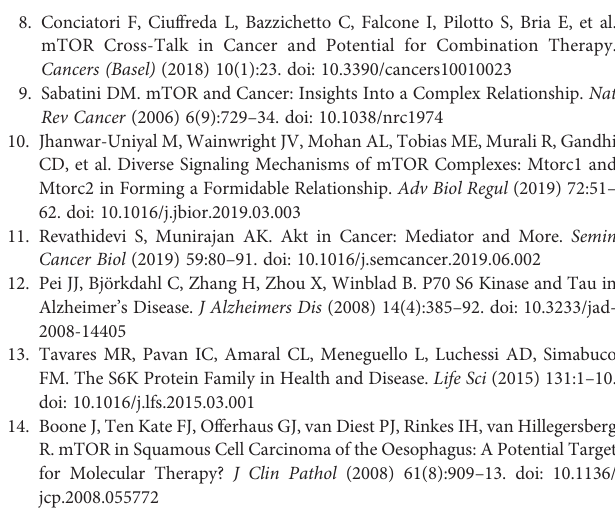
Supplementary Figure 1 | Effect of Ethyl ferulate on the activity of various kinases. (A, B) ABL, AKT1, AMPK a 1, AURUA, B-RAF, CDK2/Cyclin E, CDK4/ Cyclin D3, CHEK1, DNA-PK, EGFR, ERBB2, ERK1, FAK, FGFR1, FYN, GSK3 b , HIPK1, IKK a , JAK1, KIT, MEK1, MET, MKK6, MSK1, mTOR/FKBP12, NEK1, p70S6K, PAK4, PDK1, PI3K(p110 a /p65 a ), PIM1, PKC a , RSK2, SRC, TBK1, or TLK1 kinase and their respective substrates were incubated with or without Ethyl ferulate in an in vitro kinase assay. Data are shown as mean ± S.D of values. Supplementary Figure 2 | Expression of mTOR protein in mTOR knockdown cells. (A, B) Effect of mTOR knockdown on total or phosphorylated mTOR protein expression in KYSE450 (A) and KYSE510 (B) cells. KYSE450 and KYSE510 cells stably expressing shRNA control or shmTOR were analyzed by Western blotting. Band density was measured using the Image J (NIH) software program. For all experiments, similar results were observed from 3 independent experiments and band density is shown as a bar graph. One-way ANOVA was used to compare signi fi cant differences. Supplementary Figure 3 | Effect of Ethyl ferulate on ALT and AST activity. (A, B) The effect of Ethyl ferulate on ALT (A) and AST activity (B) was determined. Mice were orally administrated Ethyl ferulate at 50 mg/kg, 100 mg/kg, or vehicle once a day Monday through Friday for 2 weeks by the gavage method. Blood samples frommice werecollected andanalyzed. TheALTandAST activityweremeasured in mice treated with Ethyl ferulate and the vehicle-treated group. Data are shown as mean ± S.E. of values obtained from each group (n = 4). Supplementary Figure 4 | Effect of Ethyl ferulate on mice bodyweight, ALT and AST activity. (A, B) Effect of Ethyl ferulate on mice body weight. Vehicle or Ethyl ferulate at 100mg/kg was administered to mice by oral gavage, once a day for 32 (LEG110 tissue) or 53 (LEG45 tissue) days. The body weights of mice were treated with Ethyl ferulate or vehicle were measured once a week over the timespan of 32 (LEG110 tissue) or 53 (LEG45 tissue) days. (C) Ethyl ferulate exhibits no obvious toxicity in vivo . The effect of Ethyl ferulate on the ALT and AST activity were determined. Blood samples from each group (n = 7) were collected and analyzed. The ALT and AST activity were measured in mice treated with Ethyl ferulate or vehicle. All data are shown as mean ± S.E. of values obtained from experiments. Supplementary Figure 5 | Ethyl ferulate has no obvious toxicity in vivo. (A, B) H&E staining of liver, kidney, or spleen isolated from Ethyl ferulate-treated and untreated mouse groups inoculated with LEG110 (A; n = 5, 3 slides per tissue) and LEG45 (B; n = 5, 3 slides per tissue) tissues (100×; Scale bar: 100 m m). Supplementary Figure 6 | Representative diagram of the mechanism of the anti- cancer activity of Ethyl